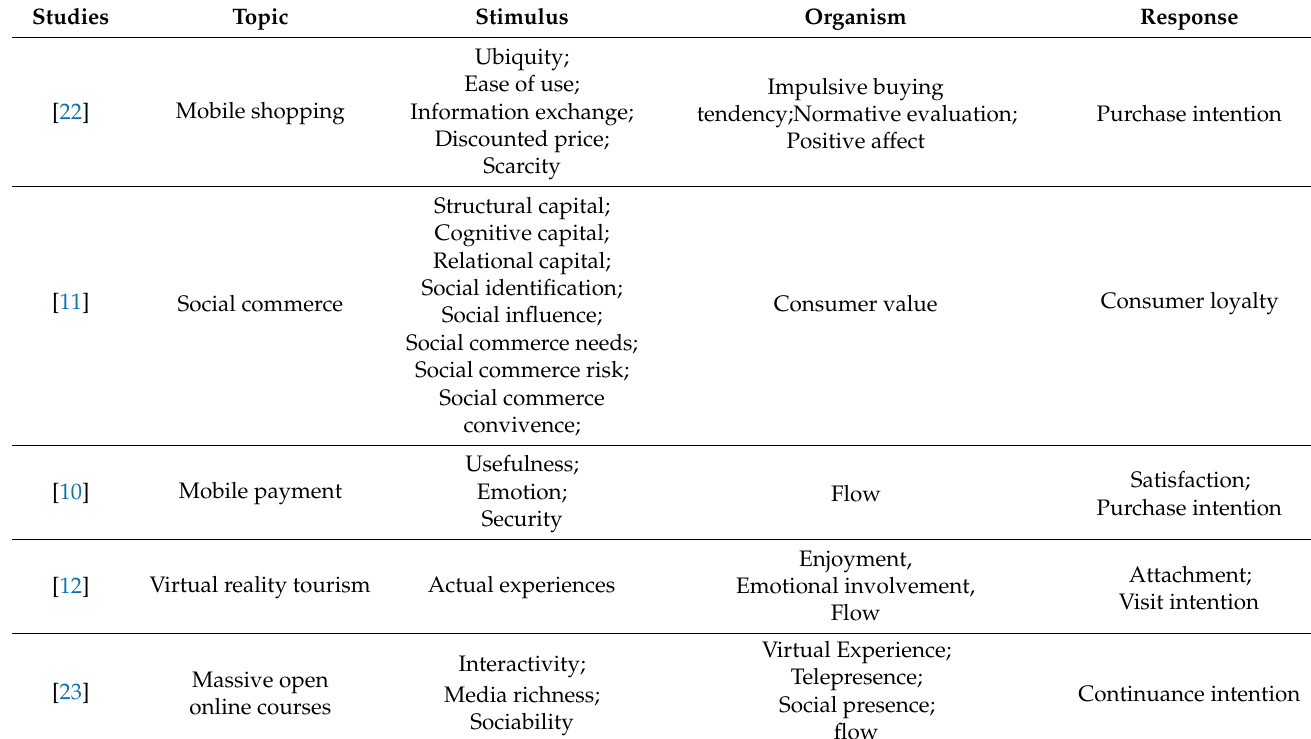
Table 1. Literature review of the SOR